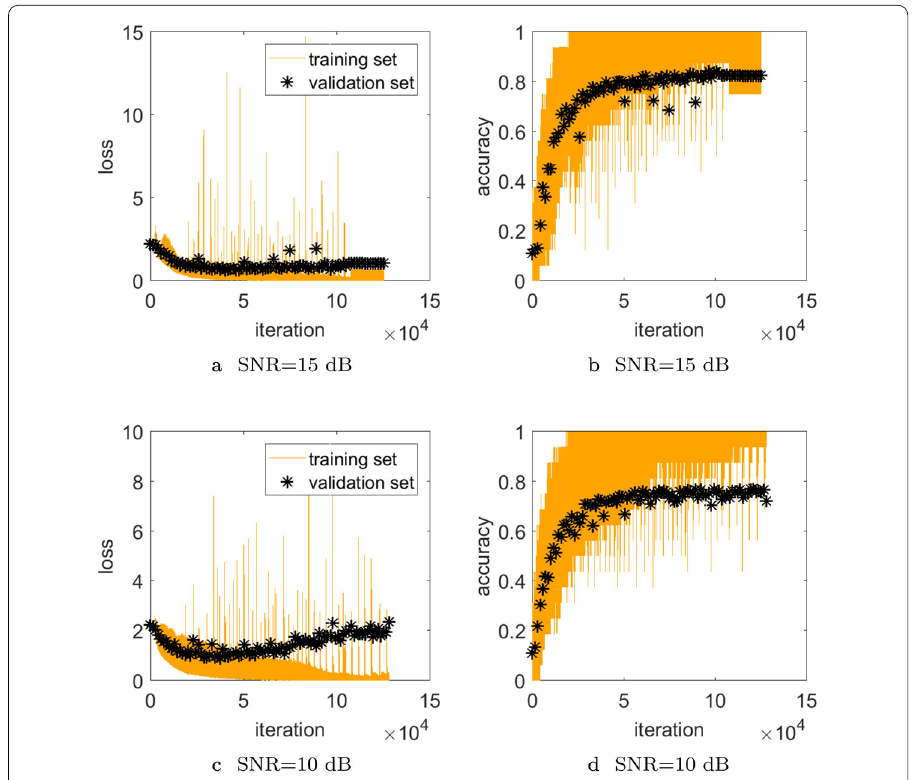
Fig. 15 Damage localization, case 1. Training and validation of the two branches convolutional architecture: evolution of the loss J l ( Y , p ) on D l and on D l (left column), and of G l accuracy A l (right column) on D l train val and on D l , both for the SNR = 15 dB case (top row) and for the SNR = 10 dB case (bottom row) val